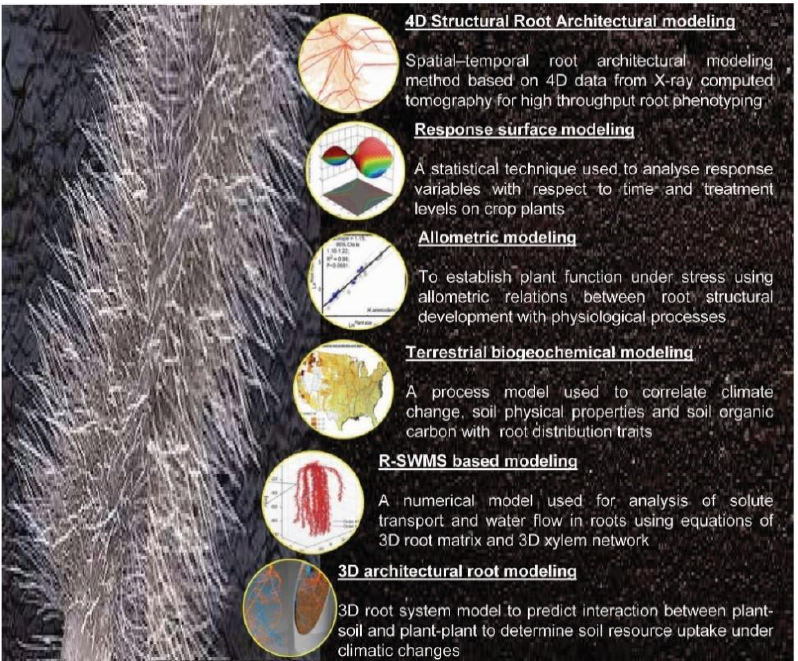
Figure 1. Schematic diagram representing the different root models used to predict root system architecture in response to various abiotic stresses. Spatial and temporal changes can be predicted through 3D/4D root models. Changes in root biomass can be predicted through allosteric models. Terrestrial biogeochemical and response surface models can be used to predict nutrient acquisition.